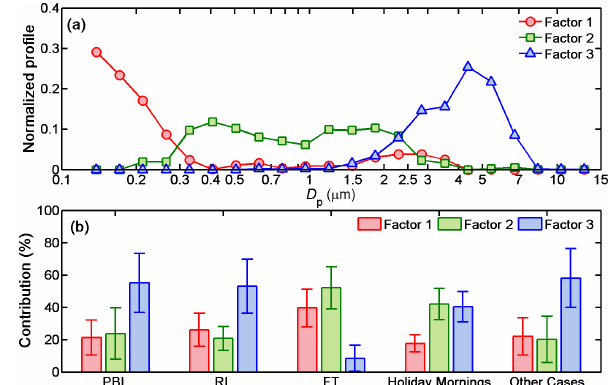
Figure 7. (a) Normalized factor profiles and (b) averaged contri- butions of each factor to the total particle mass concentrations in the PBL, the RL, and the FT in Period II and also for averages in the PBL on holiday mornings and other cases, namely non-holidays and holidays ∗ , with the error bar indicating the standard